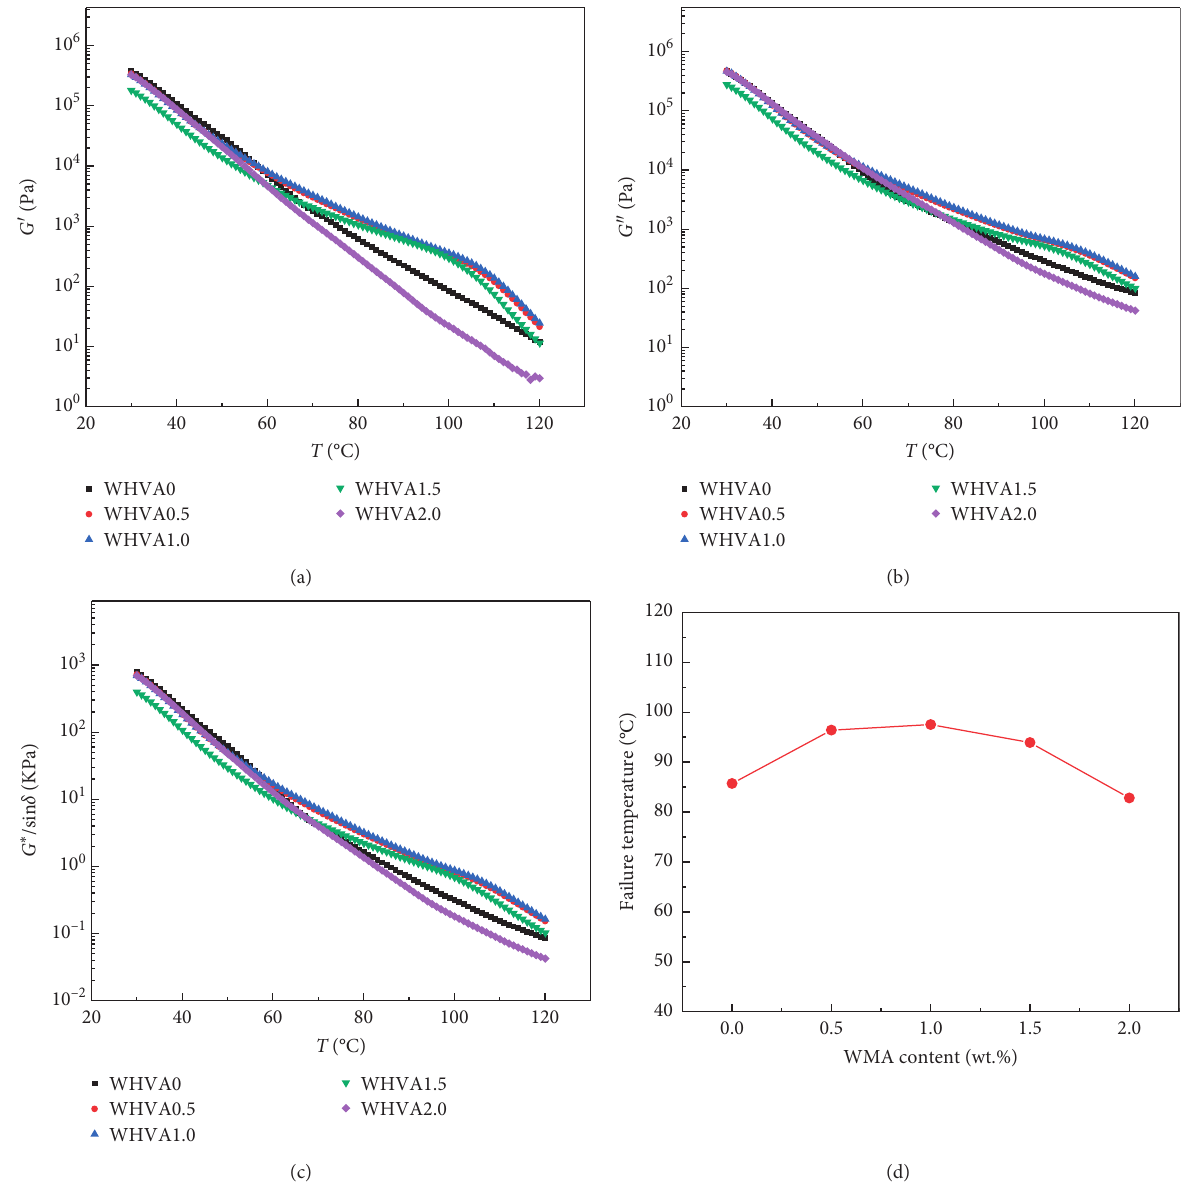
Figure 5: Evolution of (a) G ′ , (b) G ″ , and (c) G ∗ /sin δ versus temperature and (d) temperature calculated at the point of G ∗ /sin δ � 1.0kPa for warm-mix